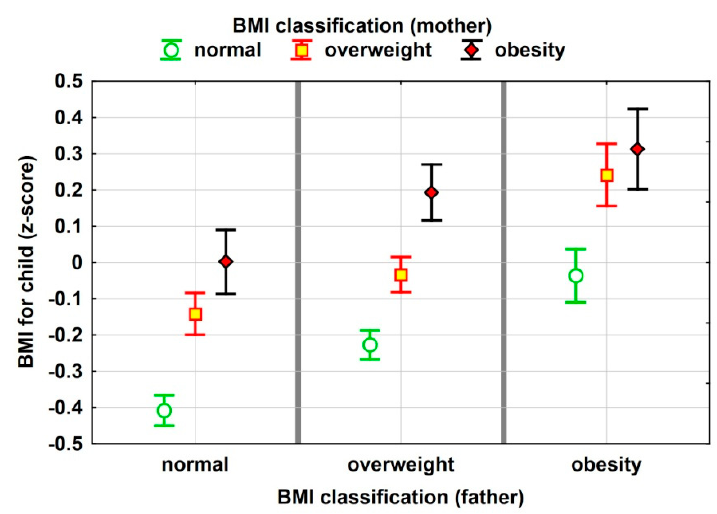
Figure 2. Mean values with 95% confidence intervals for BMI z-scores in relation to the BMI classification of both parents.